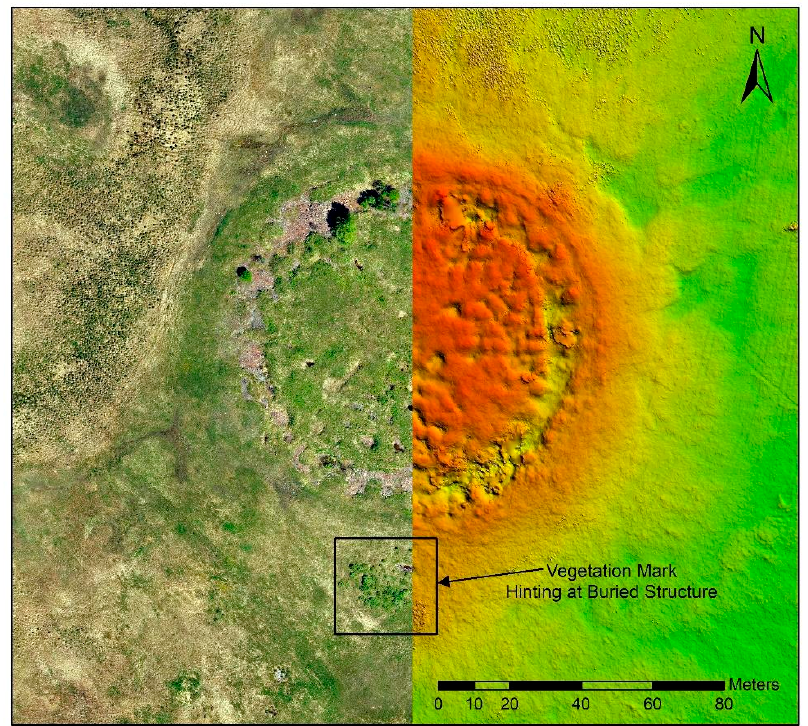
Figure 4. ( left ) Ortho-photo generated from 80 individual pictures captured by an unmanned aerial vehicle (UAV), approximate resolution 5 cm. ( right ) Digital elevation model generated with an approximate resolution of 15 cm. Note the clear vegetation mark in the southern periphery of the burial mound indicating a buried structure.